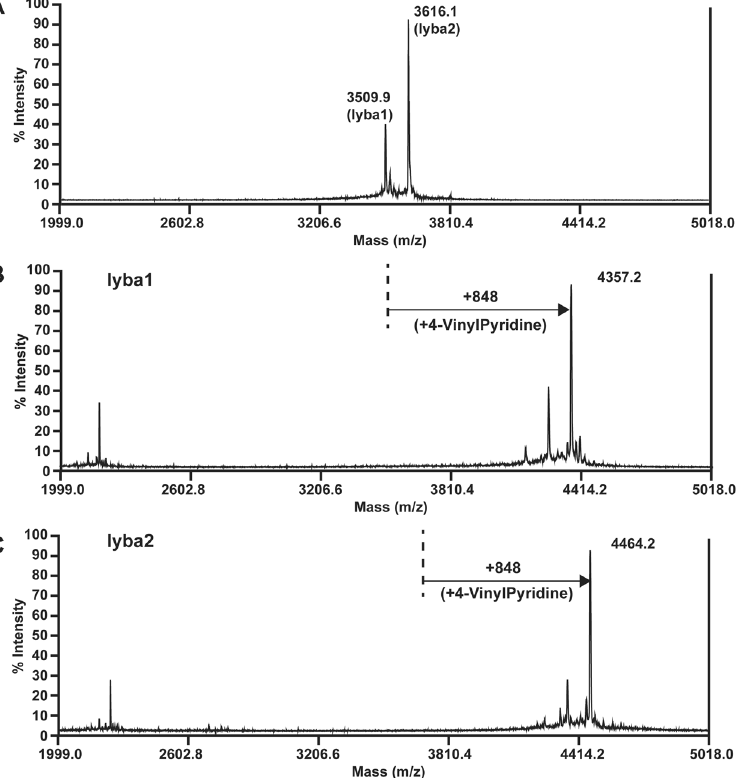
Figure 2. MALDI mass spectrum of lybatides, lyba1 and lyba2. ( A ) Mass spectrum displaying two main peaks at m/z 3509, lyba1, and m/z 3616, lyba2. ( B ) 4-vinylpyridine alkylation of lyba1 after reduction by dithiothreitol, showing a m/z shift of 848. ( C ) 4-vinylpyridine alkylation of lyba2 after reduction by dithiothreitol, showing a m/z shift of 848.